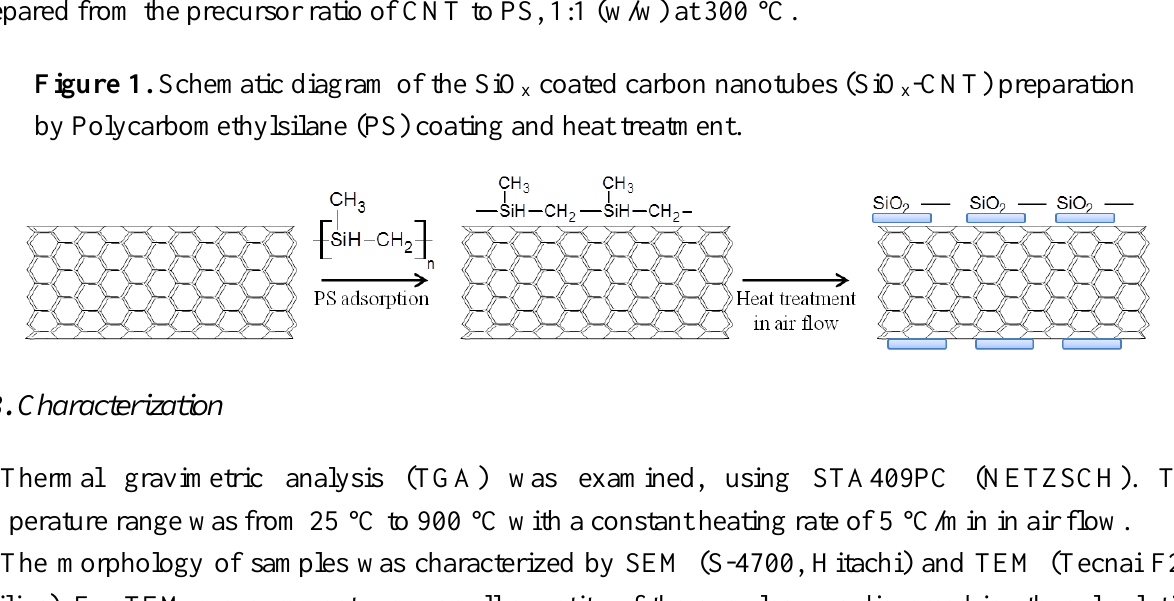
coated carbon nanotubes (SiO x